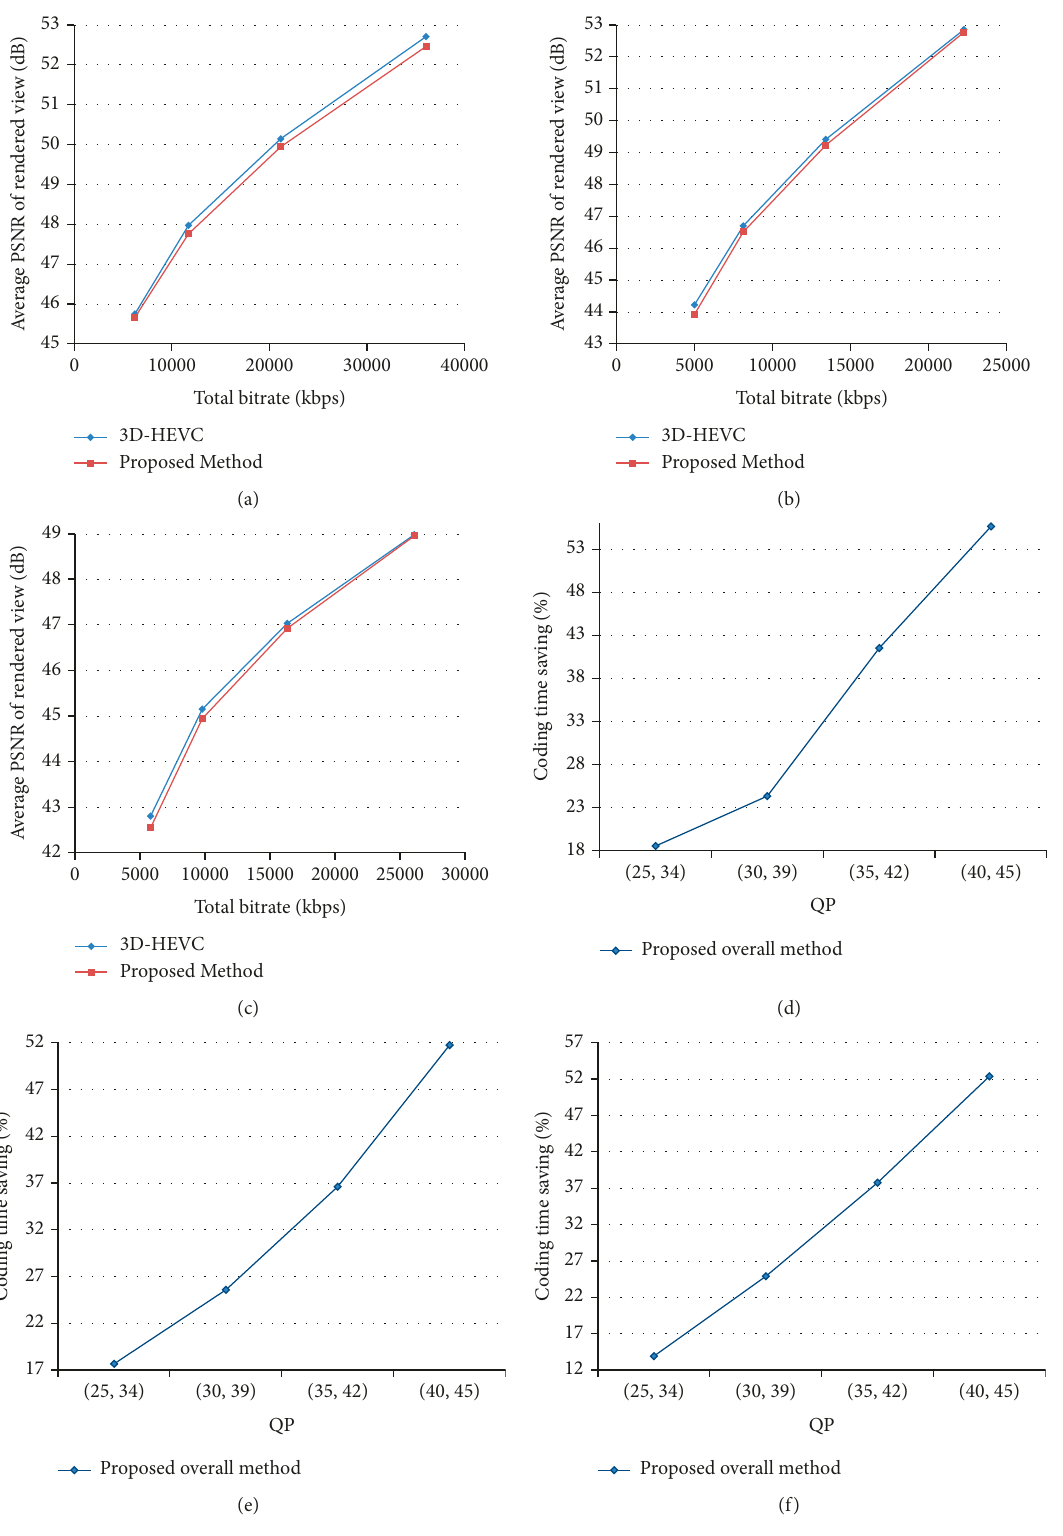
Figure 6: Rate-distortion and time-saving curves of “GTFly,” “Balloons,” and “Newspaper1” under different QPs in all intraconfiguration. (a) Rate-distortion curve of GTFly. (b) Rate-distortion curve of Balloons. (c) Rate-distortion curve of Newspaper1. (d) Time reduction curve of GTFly. (e) Time reduction curve of Balloons. (f) Time reduction curve of